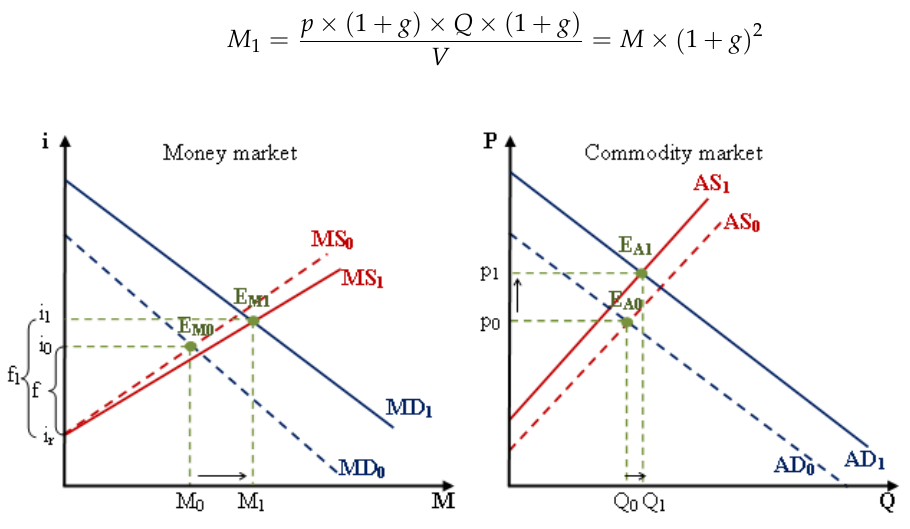
Figure 7. The steady-state equilibrium economy. From Equation (20), the monetary model may extend with the real business cycle hypothesis, in which the levels of price and quantity increase with different growth rates, growth rate as in Equation